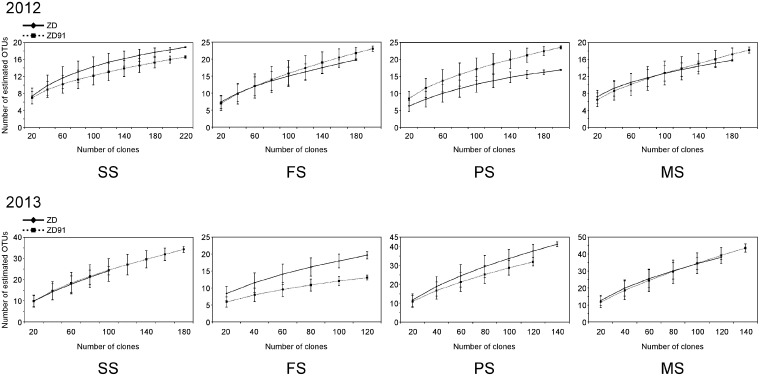
Rarefaction analysis.Rarefaction curve of the OTUs obtained from soybean rhizosphere soil of various cultivars. Nucleotide sequences with greater than 97% identity were referred as the same OTU. SS: seedling stage; FS: flowering stage; PS: pod-setting stage; MS: maturity-setting stage.